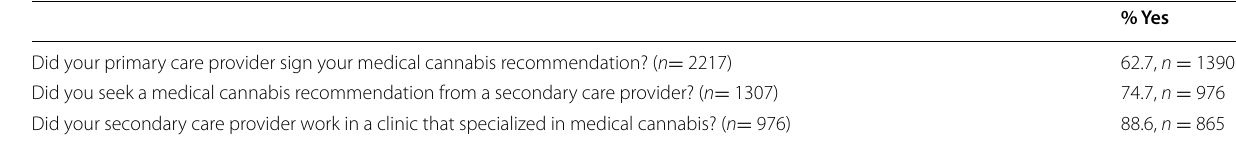
Data include patients who answered “no” to “Did your primary care provider sign your medical cannabis recommendation?”